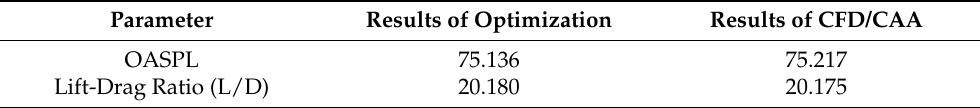
Table 8. Optimization results are validated by Table 7. Comparison of initial shape and optimized shape.